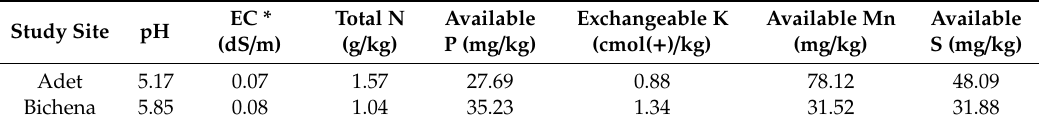
Table 1. Soil chemical properties of the test sites in the top 0–15 cm depth.